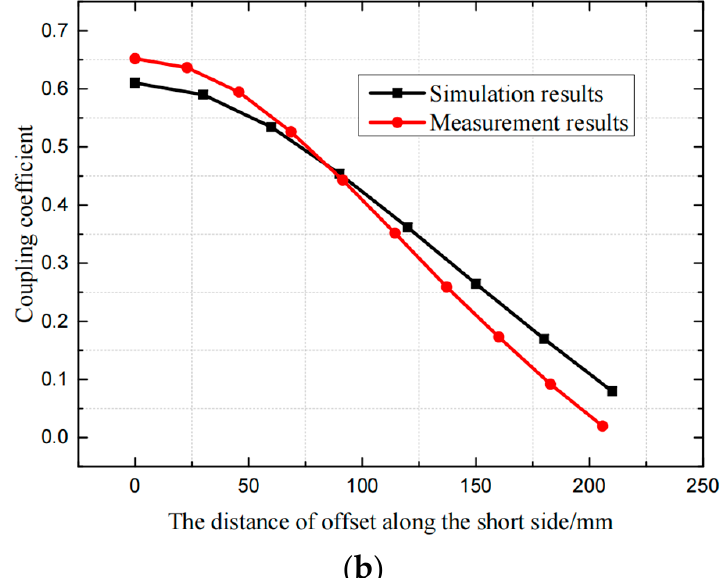
Figure 22. Comparison of measured and simulated results of magnetic coupling mechanism: ( a ) offset along the long edge, ( b ) offset along the short edge.